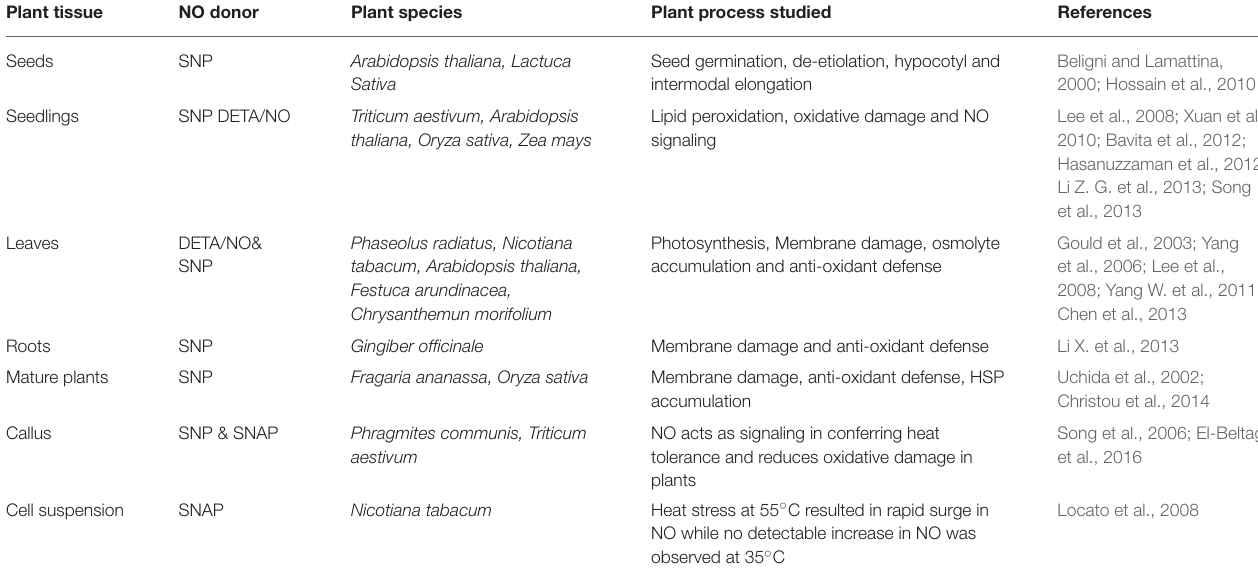
TABLE 4 | Different types of plant tissues used for nitric oxide treatment in plant heat stress studies. Plant